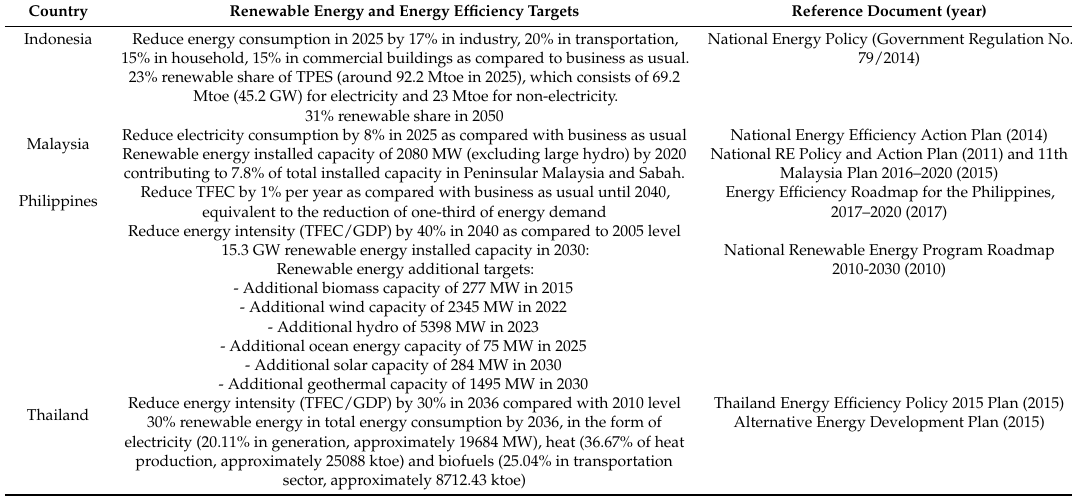
Table 2. Renewable energy and energy efficiency targets in four selected ASEAN countries